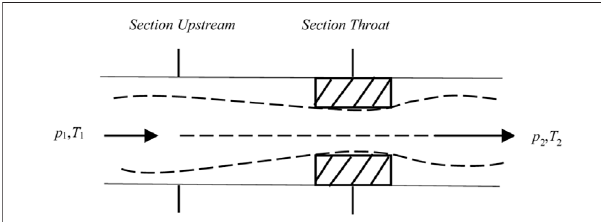
FIGURE1| Throttlingschematicdiagramoftheinternal fl owchannelofa single throttling hole.